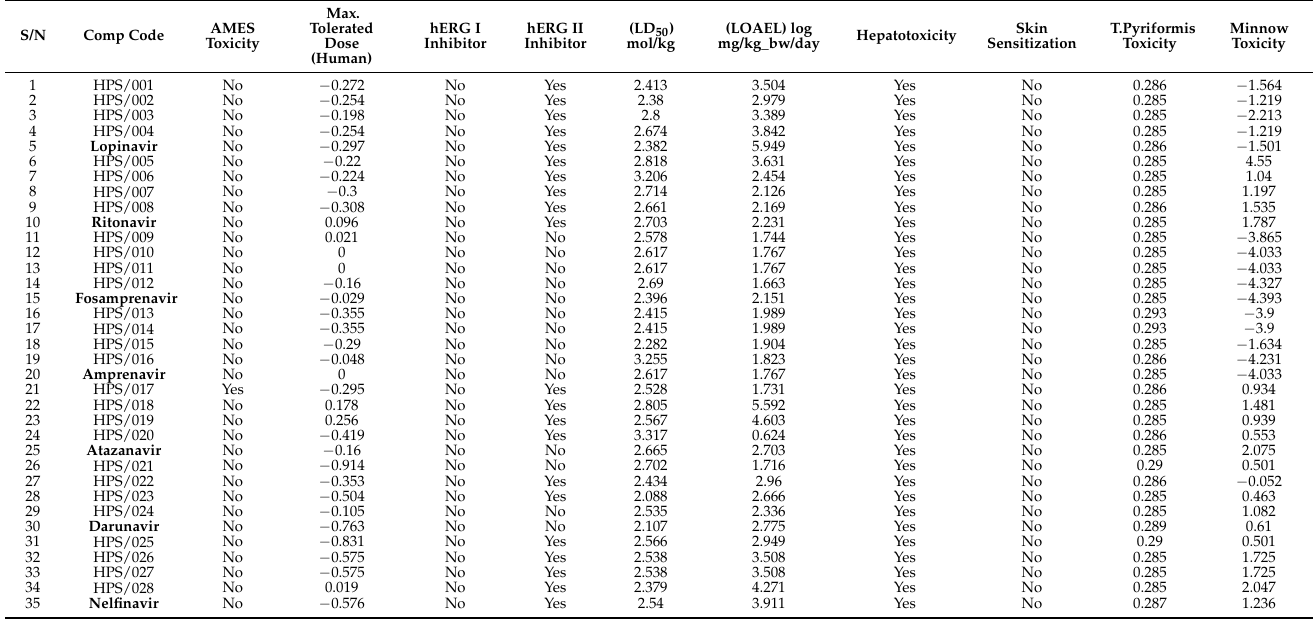
Table 7. The results of the toxicity evaluation with